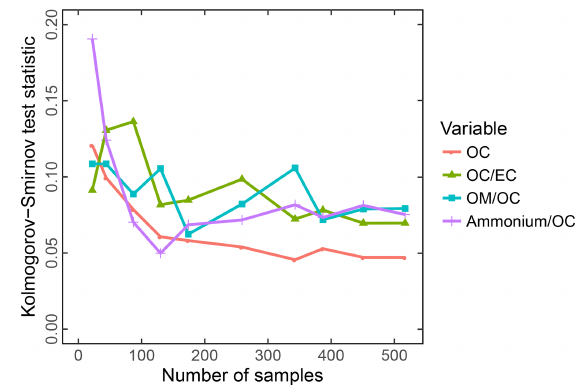
Figure 10. Kolmogorov–Smirnov (KS) test statistic for different numbers of calibration samples used in Fig. 9. The KS statistic char- acterizes the difference between two empirical distribution func- tions, in this case determined for probability distributions of each variable between the calibration and test set